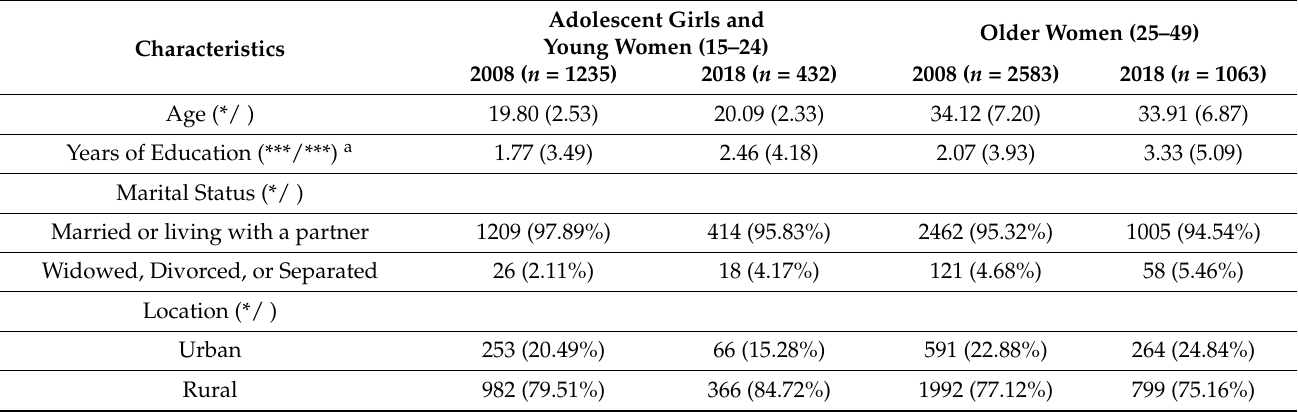
Table 1. Demographics by Age Group and Data Collection Year of Ever-partnered Female Respon- dents who Completed the Domestic Violence Module in Northeast, Nigeria (mean (SD) or frequency (% within the